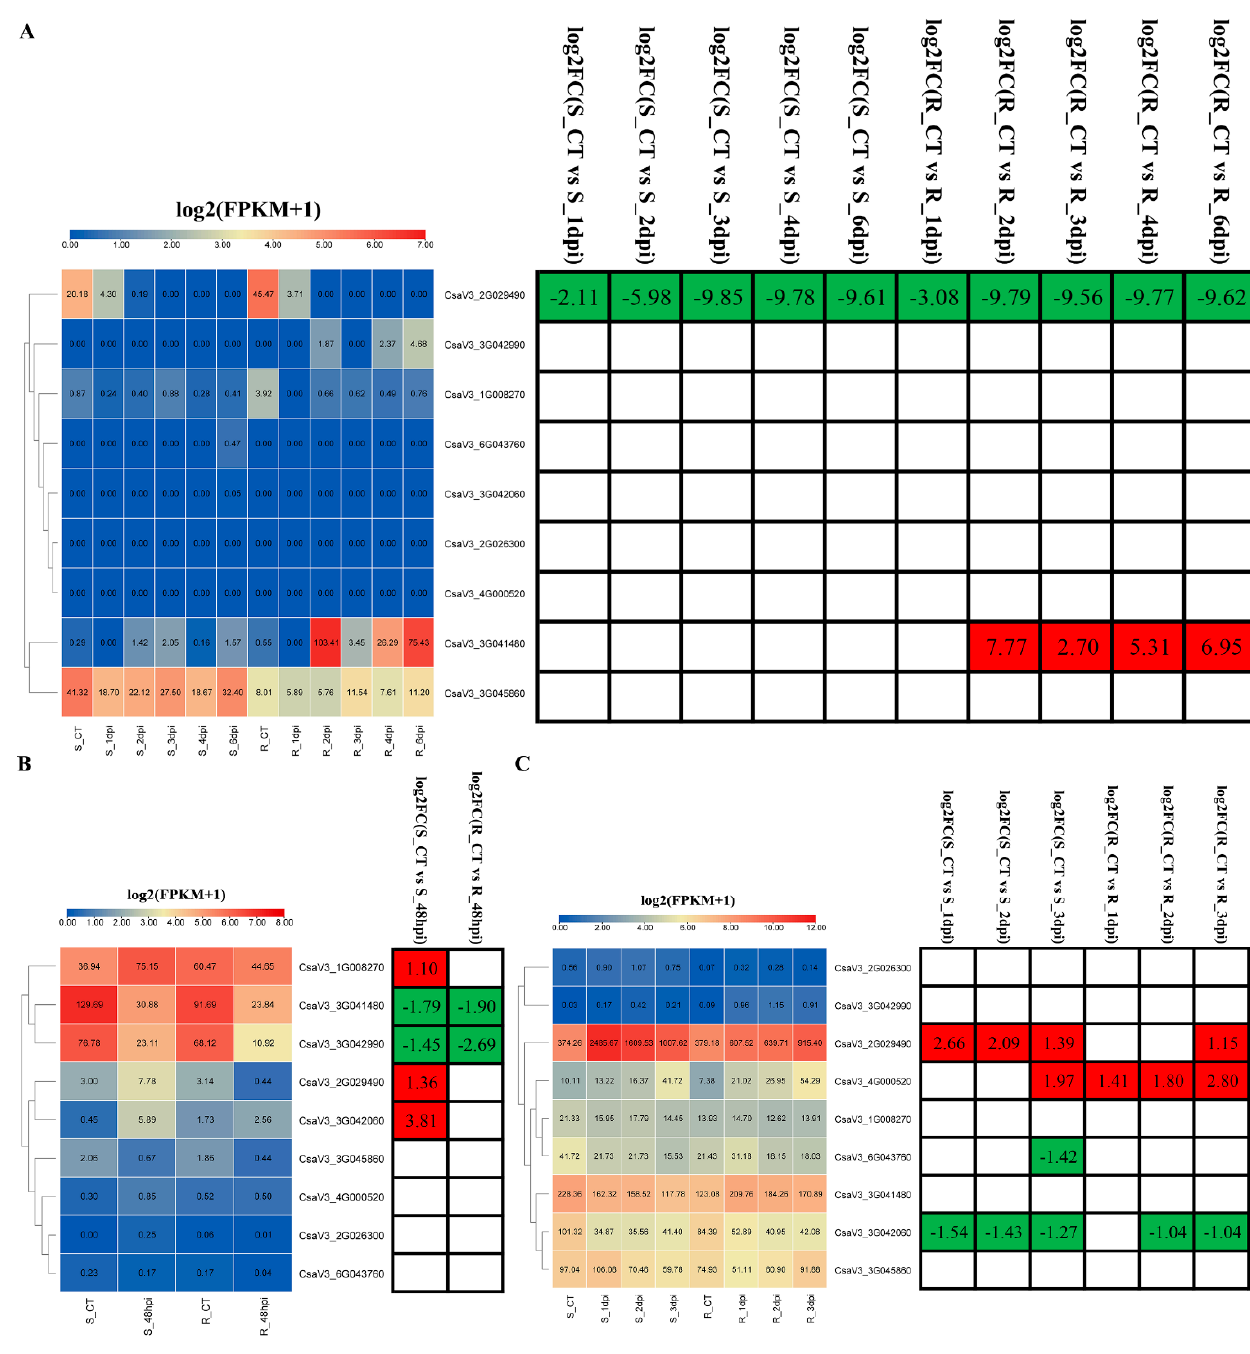
Figure 8. Expression heatmaps of cucumber GASA family genes under biotic stresses. ( A ) Expression patterns of cucumber GASA family genes under downy mildew stress. ( B ) Expression patterns of cucumber GASA family genes under powdery mildew stress. ( C ) Expression patterns of cucumber GASA family genes under root-knot nematode stress. S: susceptible plants; R: resistant plants; 1 dpi, 2 dpi, 3 dpi, 4 dpi and 6 dpi are 1, 2, 3, 4 and 6 days post inoculation, respectively; CT: control; 48 hpi: 48 h post inoculation. In each figure, the data in the left boxes indicate the original FPKM values. The data in the right boxes are log2(fold-change) values highlighted by red (up-regulation) and green (down-regulation) colors.